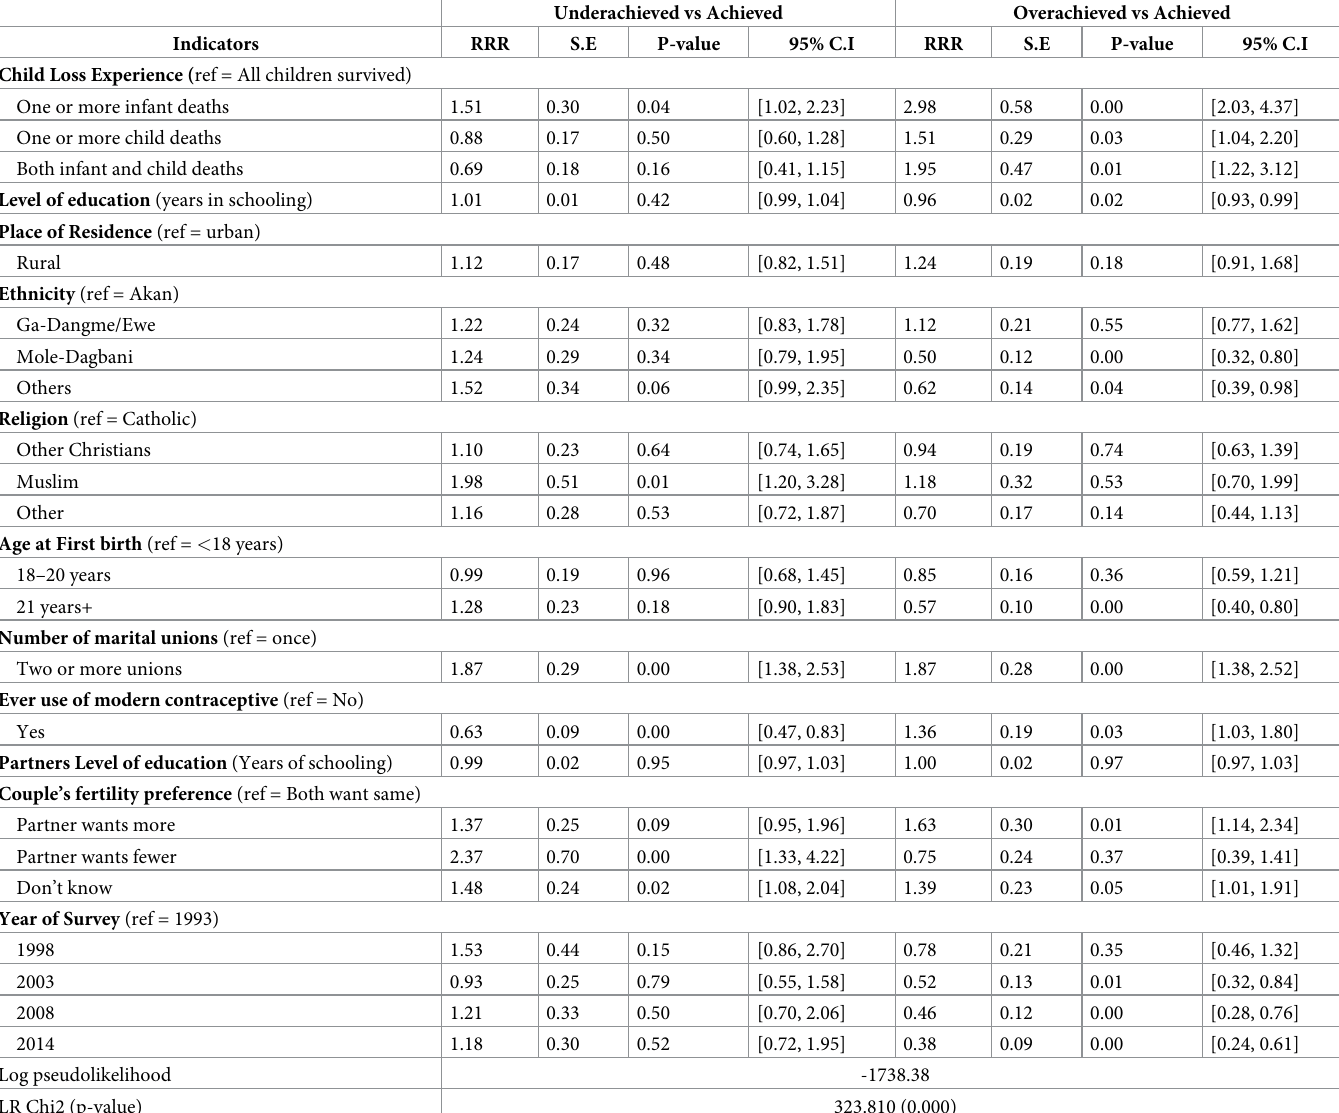
Table 2. Results of multinomial logistic regression of fertility gap in Ghana between 1993, 1998, 2003, 2008 & 2014. Underachieved vs Achieved Overachieved vs